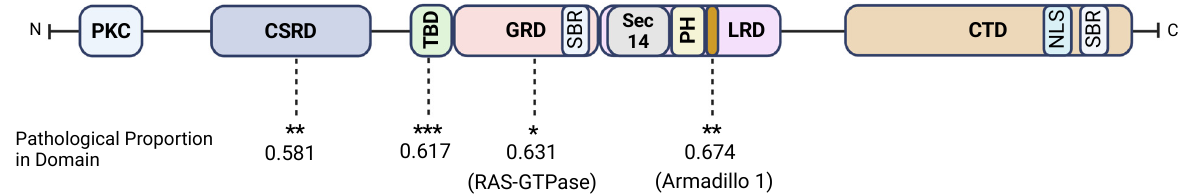
Figure 2. Pathological proportion in neurofibromin domains. Based on the 0.52 threshold obtained as reported in M&M and using p -values up to 0.1 as the cut-off for significance, our analysis identified four hotspots. The RAS-GTPase domain p < 0.01* (0.003), the CSRD domain and the Armadillo1 domain with p > 0.01 and p < 0.05**, and the TBD with a p > 0.05 and < 0.1*** (0.078).